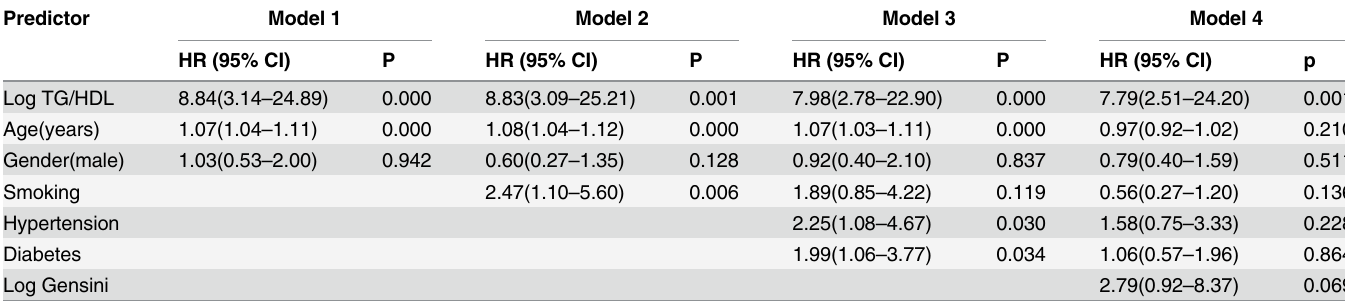
Table 3. Cumulative incidence of the composite endpoint of all-cause death by TG/HDL-C. Predictor